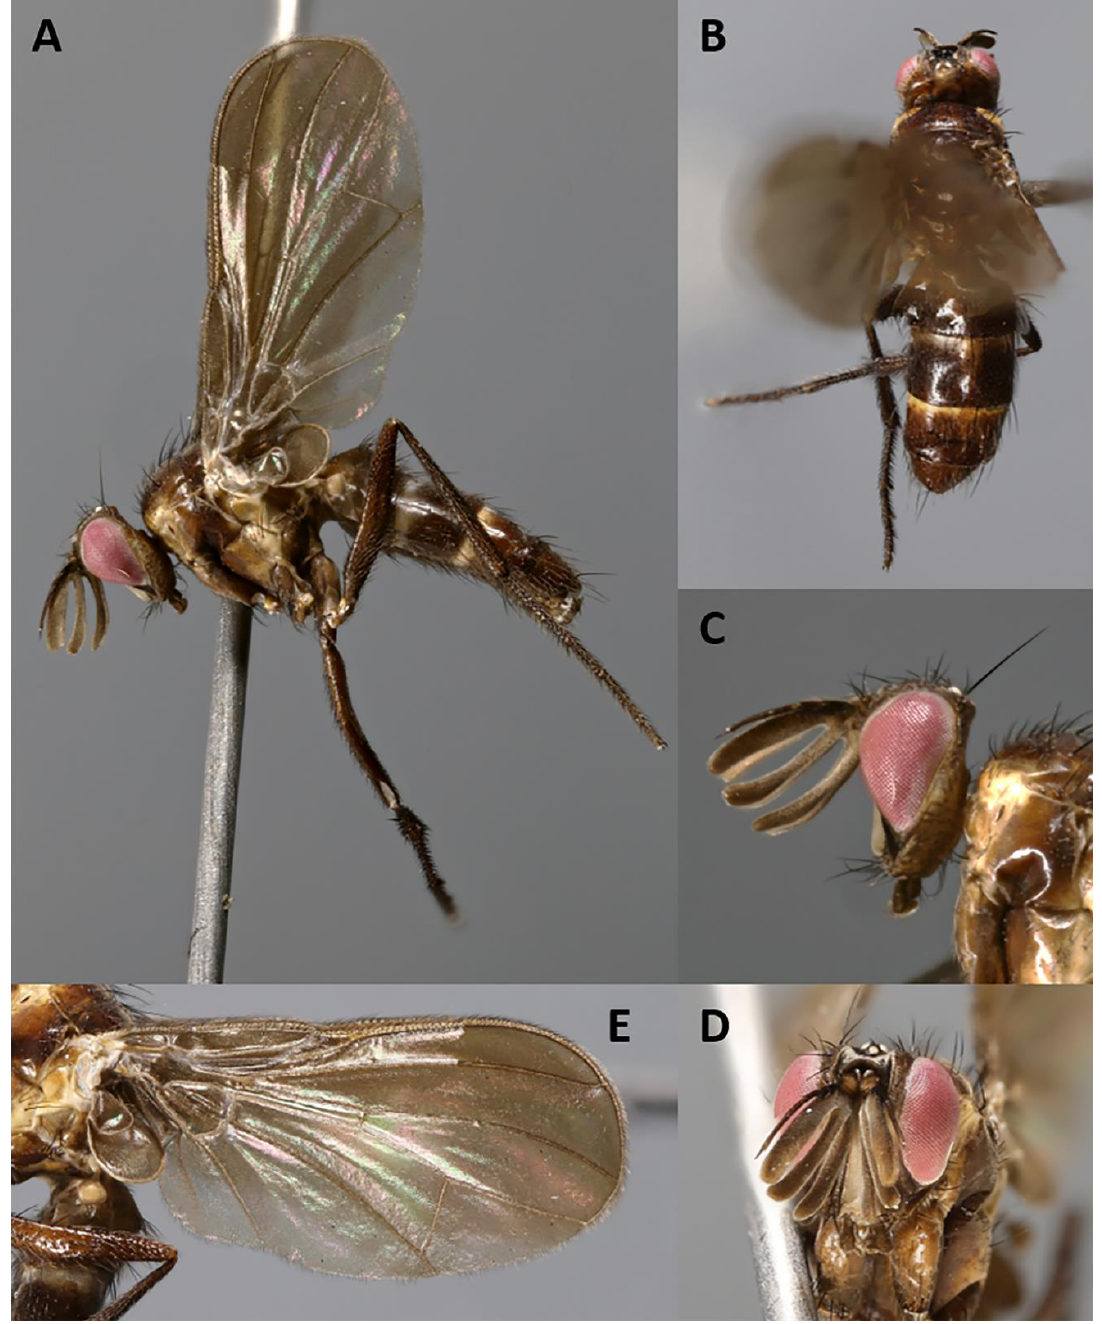
Figure 2. Aporeomyia elaphocera sp. nov. (paratype ♂ , MZUR). ( A ) Habitus in lateral view; ( B ) dorsal habitus; ( C ) head in lateral view; ( D ) head in frontal view; ( E ) left wing in ventral view.